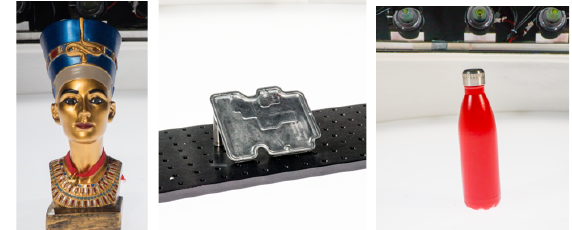
Figure 6: Examples of some objects digitized with the realized DI-ONE multi-camera system.